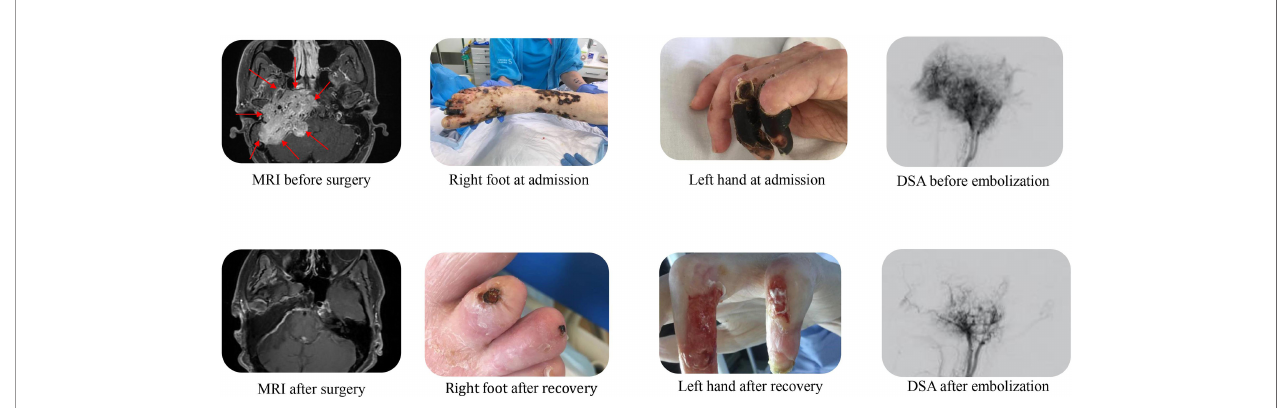
FIGURE 2 | Before and after; MRI scans, pictures of scores, and DSAs. MRI (magnetic resonance imaging) scans before and after tumor resection, clinical pictures of sores on right foot and left hand at admission and at end of hospitalization, and DSA (Digital Subtraction Angiography) images before and